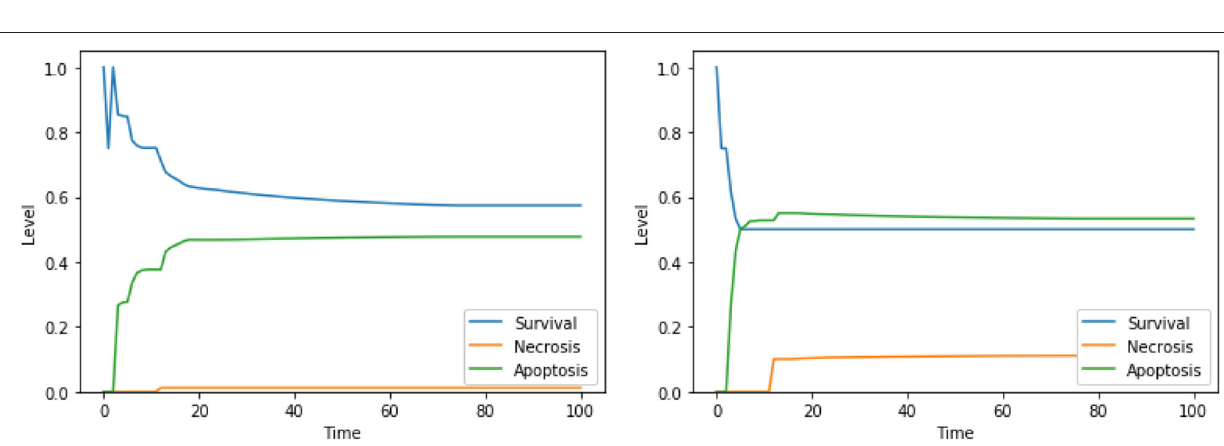
NSGA-II algorithm for multi-objective optimization. Our